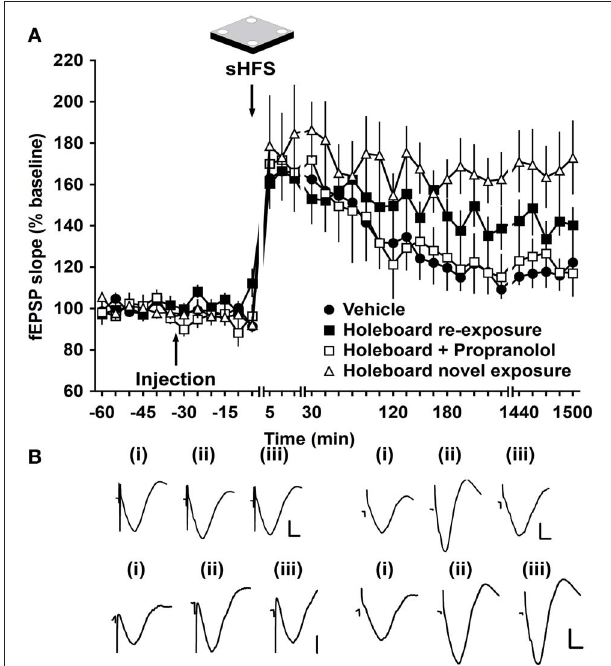
FIGURE 6 | Learning-facilitated LTP in mossy fiber synapses is regulated by β -adrenergic receptors. (A) In control experiments, application of sHFS (two trains of 100 pulses given at 100Hz) in the absence of a novel holeboard (and in the presence of vehicle) elicits STP. The combination of sHFS with novel holeboard exploration facilitates STP into LTP. Injection of propranolol before novel exploration of an empty novel holeboard elicits STP that is similar to that seen in vehicle-injected controls. A second exposure to the holeboard (ca. one week after the original treatment with propranolol) facilitates LTP. Line breaks indicate changes in time scale. (B) Analog traces recorded (i) 5min pre-sHFS, (ii) 5min post-sHFS, and (iii) 24h post-sHFS, from a vehicle-injected animal in the absence of holeboard ( left upper panel ), from a propranolol-treated animal that was exposed to a novel empty holeboard ( right upper panel ), from an animal that was re-exposed to a novel empty holeboard ca. one week after the treatment with propranolol ( lower left panel ) and from an animal that was exposed to a novel holeboard for the first time ( lower right panel ). Vertical scale bar: 2mV, horizontal scale bar: